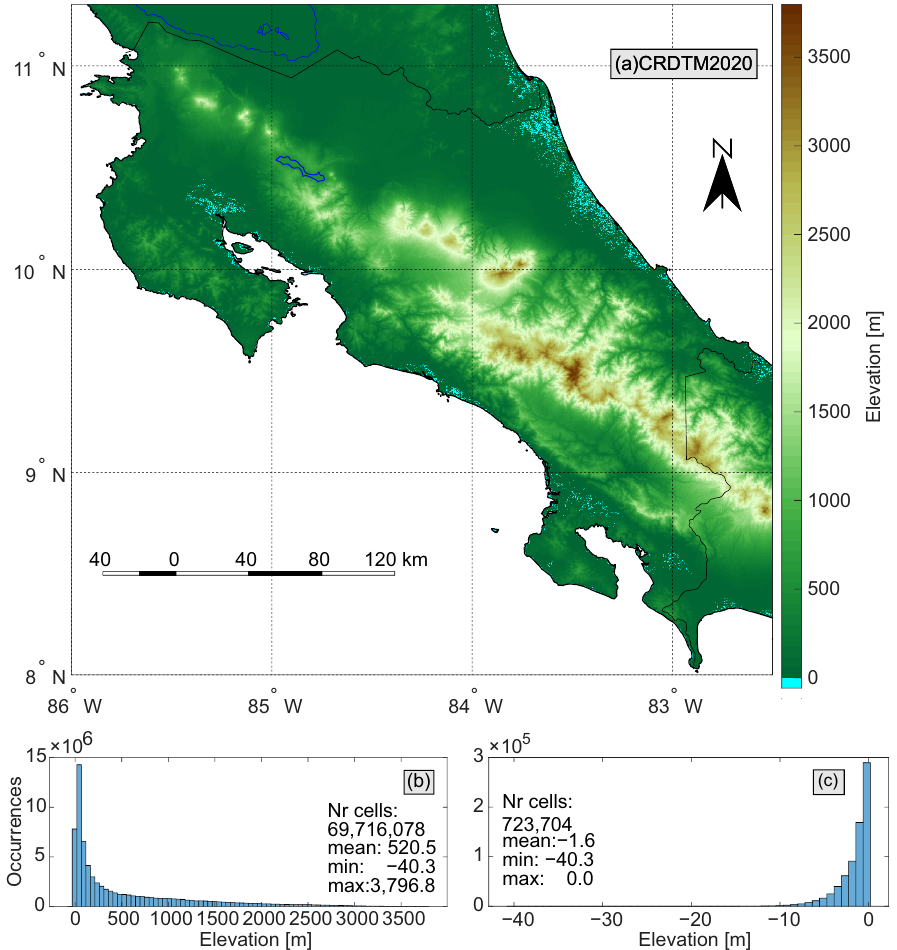
Figure 13. ( a ) CRDTM2020. ( b ) Distribution of CRDTM2020 elevations. ( c ) Distribution of the negative elevations in